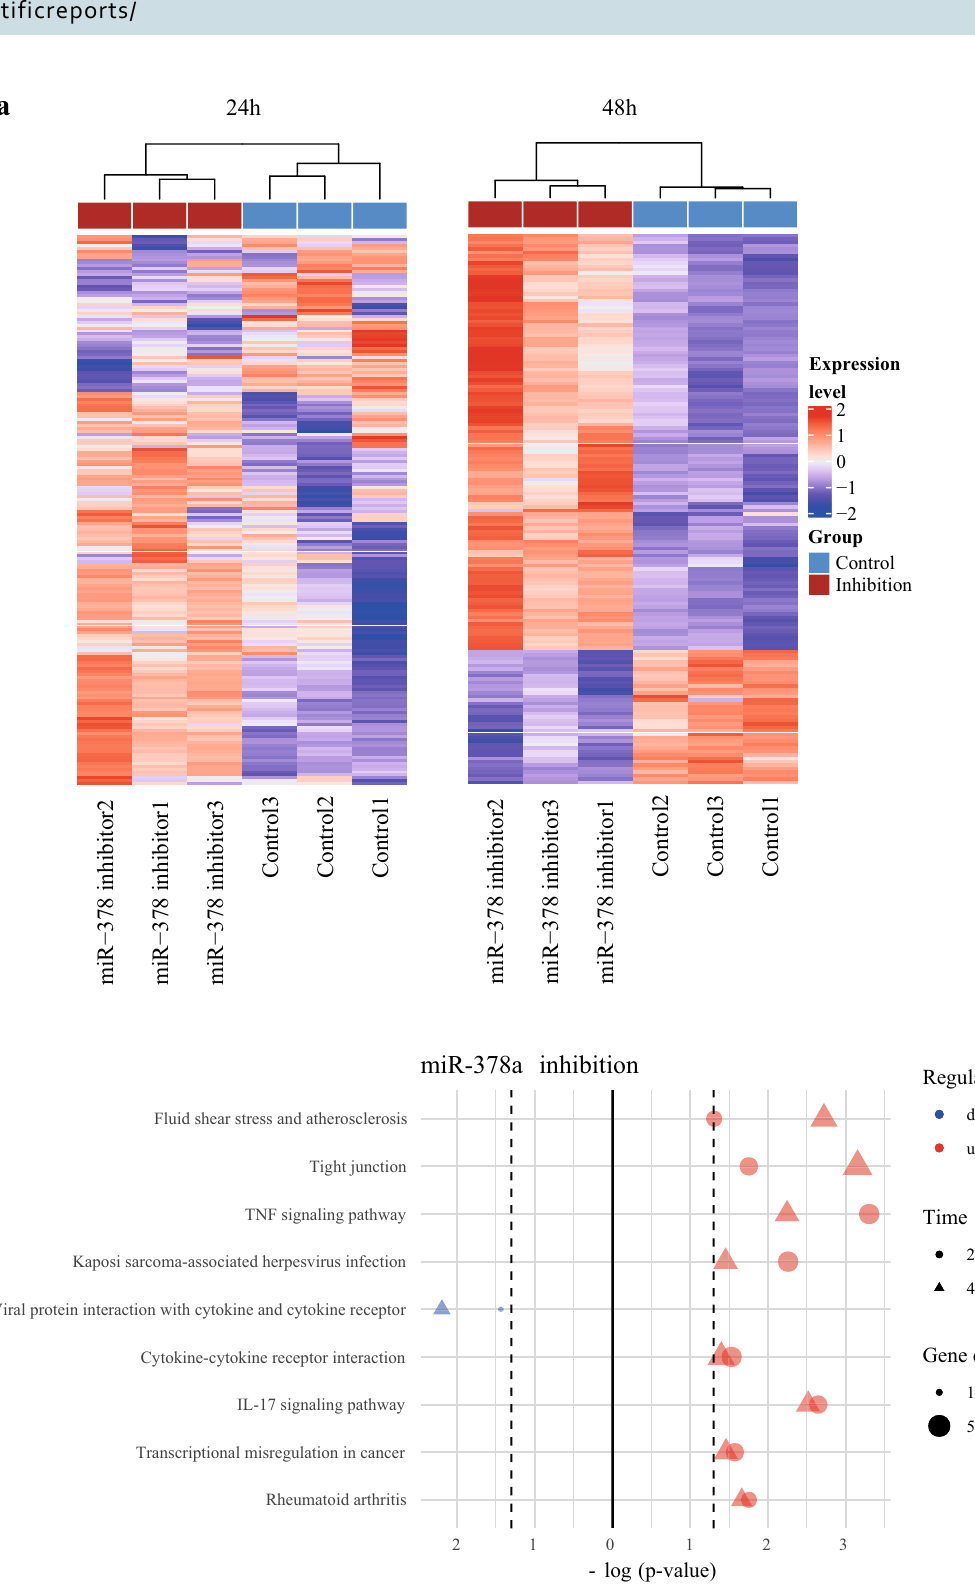
Figure 4. The gene expression profiles in miR-378a suppressed NHEK cells. ( a ) Heatmap of DEGs in keratinocytes with miR-378a suppressing for 24 h (186 genes with |log(fold-change)| > 1; left) and 48 h (160 genes with |log(fold-change)| > 1.5; right). The heatmaps were drawn using ComplexHeatmap R package. ( b ) The top overlapped KEGG pathways associated with up- and down-regulated genes at both 24 h and 48 h post- transfection of miR-378a inhibitor. The figures were drawn using tidyverse R